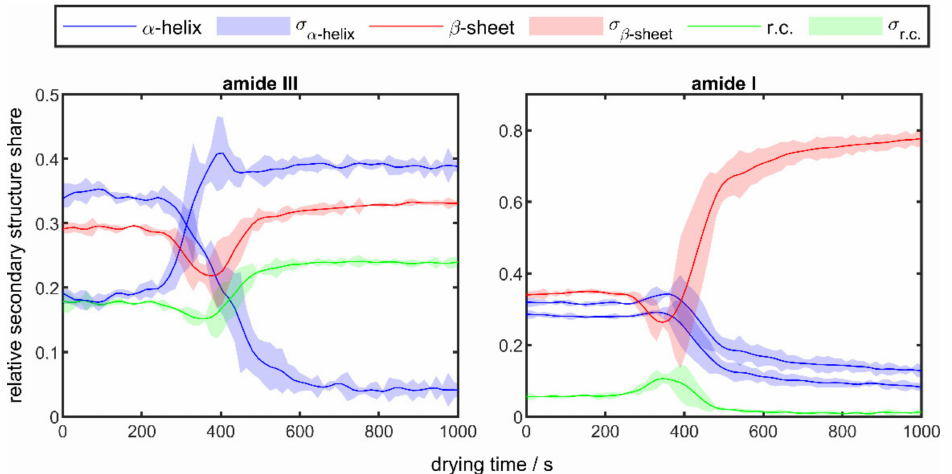
Figure 6. Temporal changes of the relative secondary structure shares in the amide I ( right ) and amide III ( left ) band of 10 wt% poly-L-lysine droplets at a drying temperature of 50 ◦ C. The solid lines show the average values of the structure fractions from the